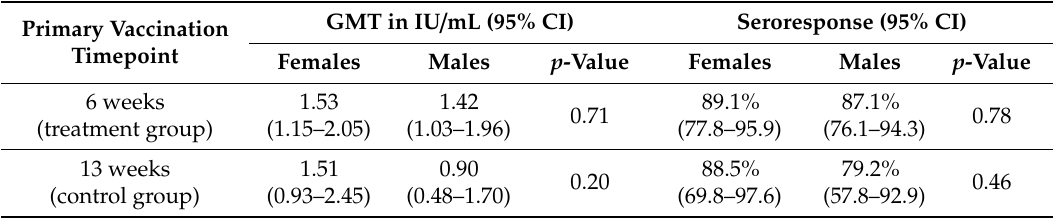
Table 3. Rabies virus neutralizing antibody titers (RVNA) by sex 21 days after primary vaccination with rabies vaccine, showing geometric mean titers (GMT) and percentage seroresponding (RVNA titers ≥0.5 IU/mL).